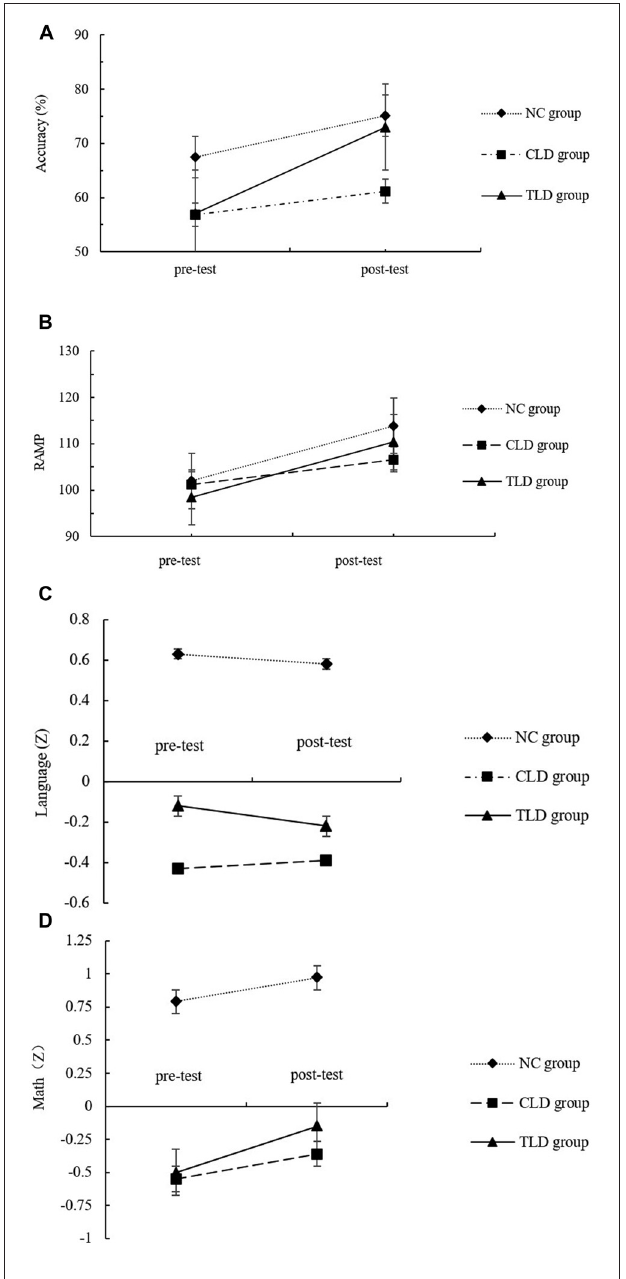
FIGURE 4 | The performance of 2-back task (A) , Raven’s advanced progressive matrices (APM; B ), language grade (C) and math grade (D) at pretest and posttest for each